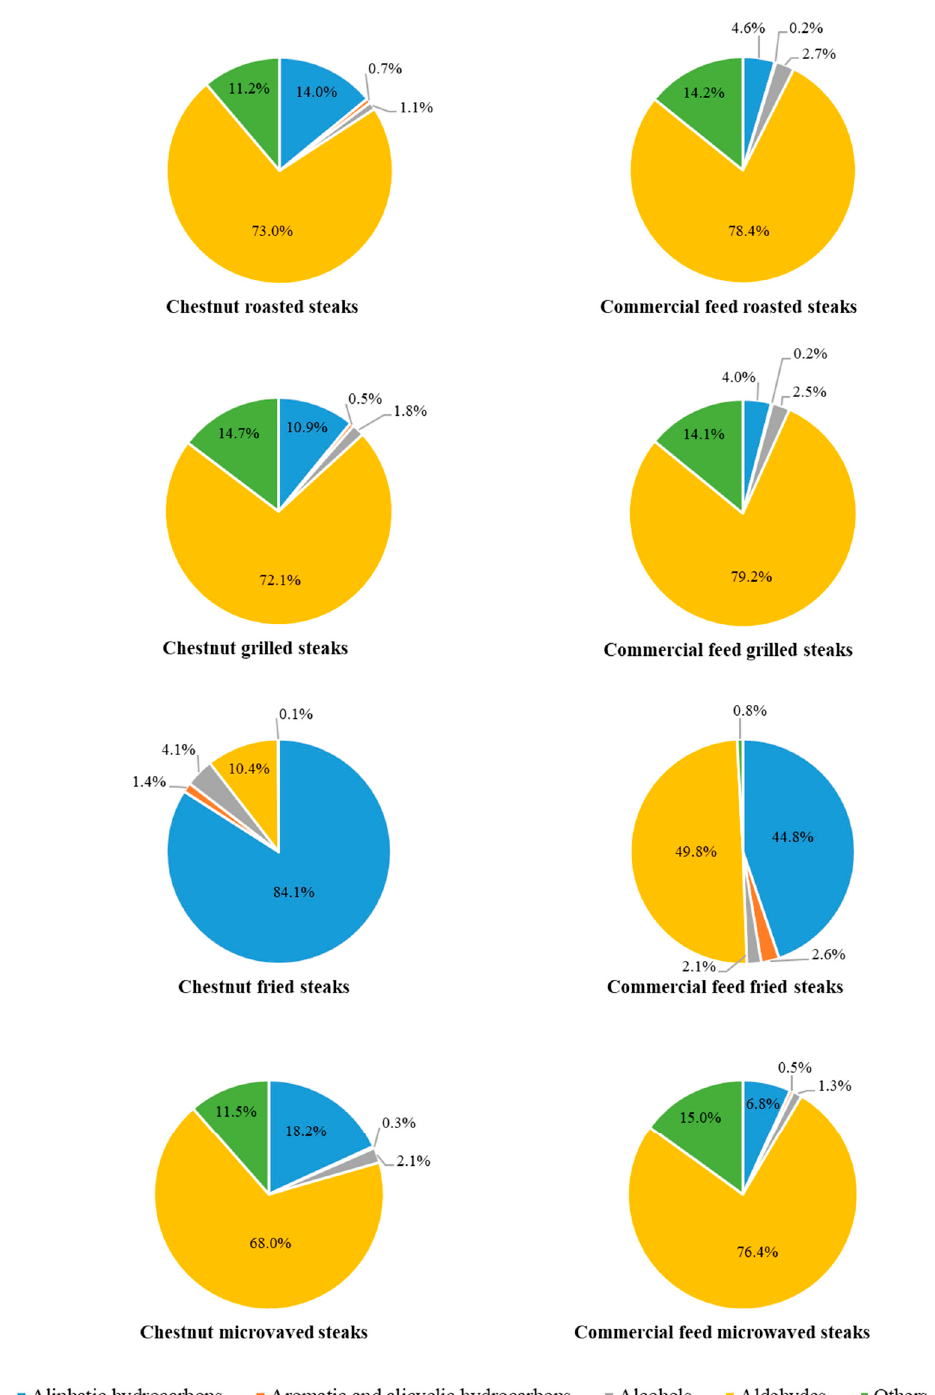
Figure 3. Volatile families of Celta pig Biceps femoris (expressed as percentages) affected by diet and by cooking method.